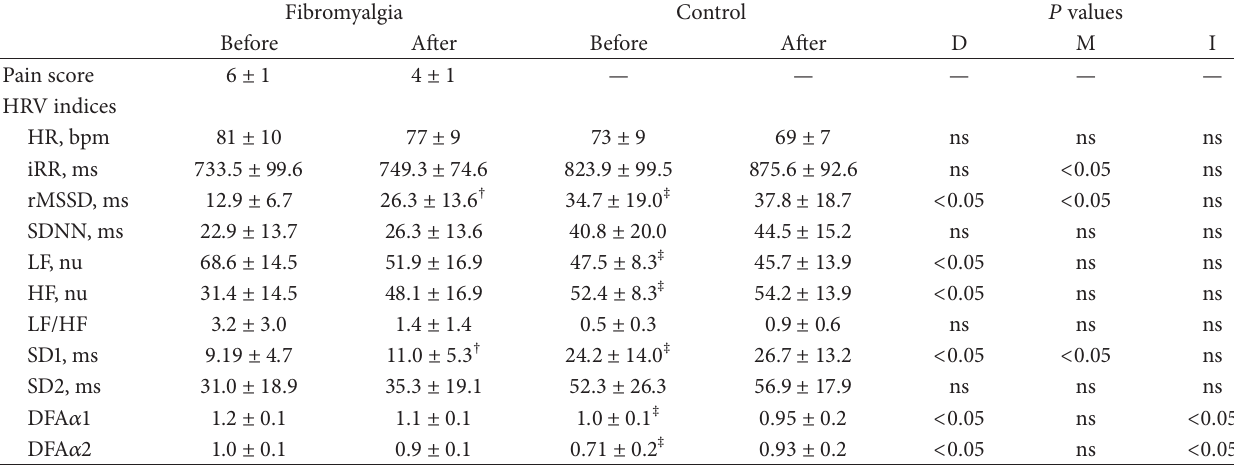
Table 2: Pain assessment and linear and nonlinear indices of heart rate variability before and after posteroanterior glide mobilization.